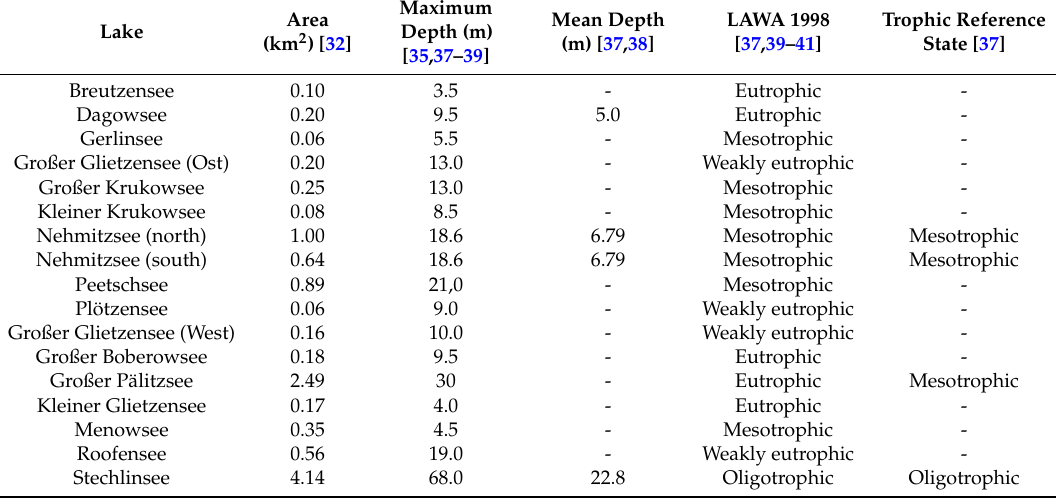
Table 3. Overview of morphology and limnological characteristics of the lakes in Rheinsberg Lake Region.